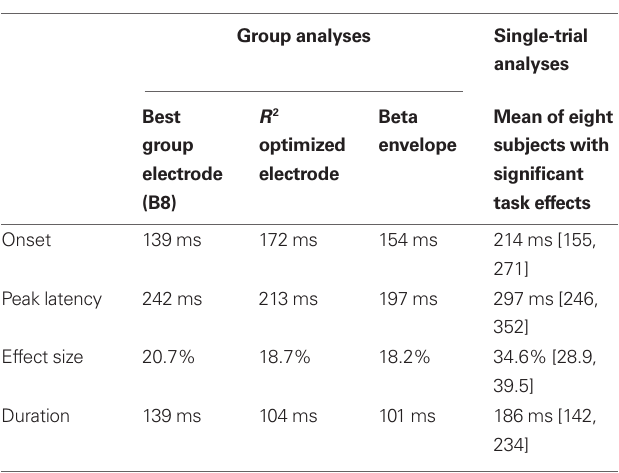
Table 1 | Task effects.